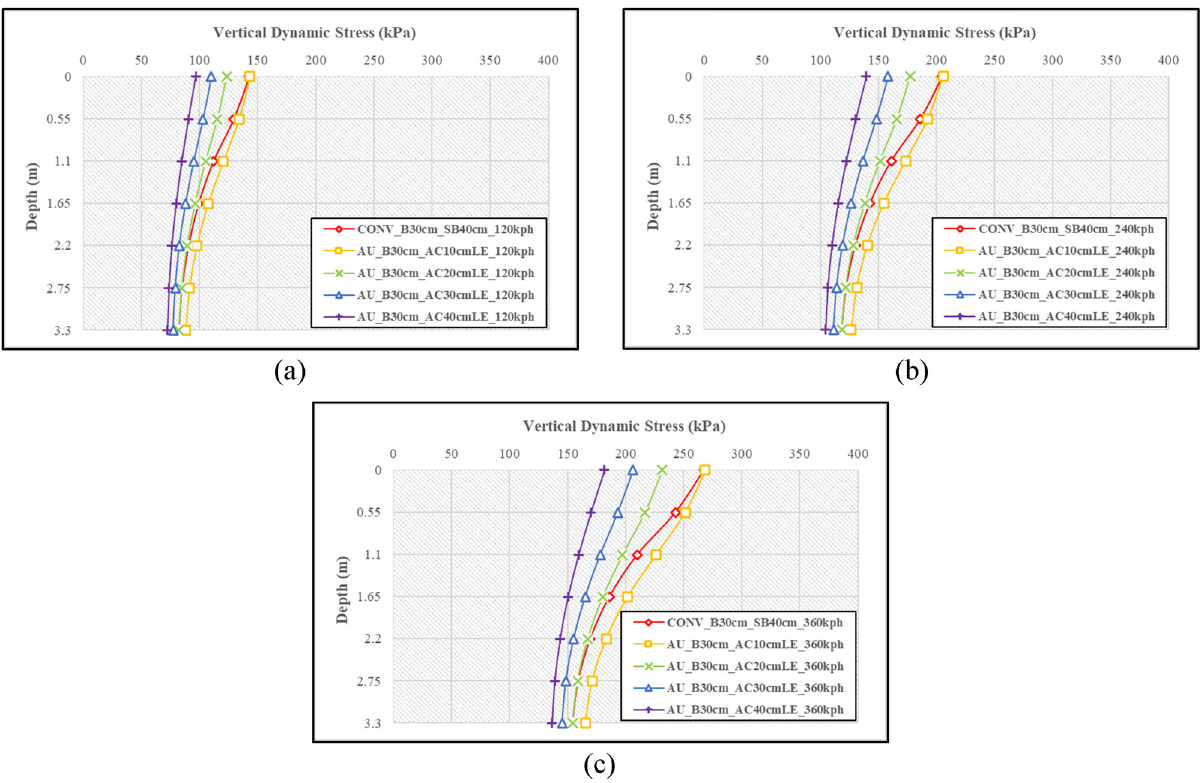
Figure 9: Vertical compressive stress curve in subgrade layer of Indonesia ’ s ballasted track and asphaltic underlayment track with 10, 20, 30, and 40 cm of AC layer: ( a ) 120 kph, ( b ) 240 kph, and ( c ) 360